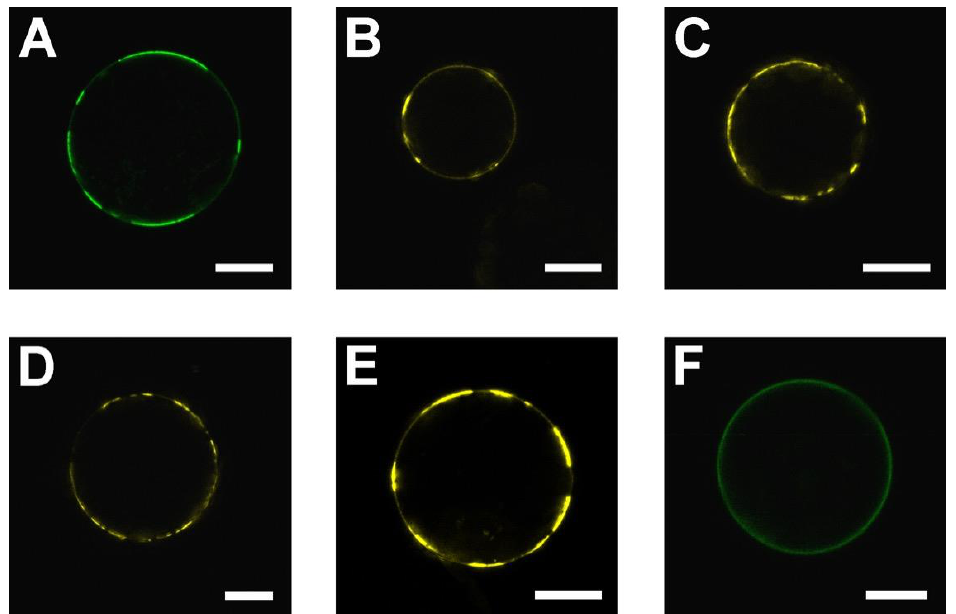
Figure 7. Impact of the SAUL1 N-terminus on its tethering function. ( A ) GFP fluorescence of SAUL1∆N-GFP expressed in mesophyll protoplasts. ( B – E ) BiFC analysis of the interplay between SAUL1 and different E2s. Mesophyll protoplasts transformed with BiFC constructs containing SAUL1 paired with UBC10 ( B ), UBC28 ( C ), UBC29 ( D ), and UBC30 ( E ). SAUL1 was always tagged C-terminally, whereas different UBCs were tagged at the N-terminus. ( F ) GFP signal of U-box-GFP-ARM 7-11 following the expression in mesophyll protoplast. Scale bars represent 15 µm.